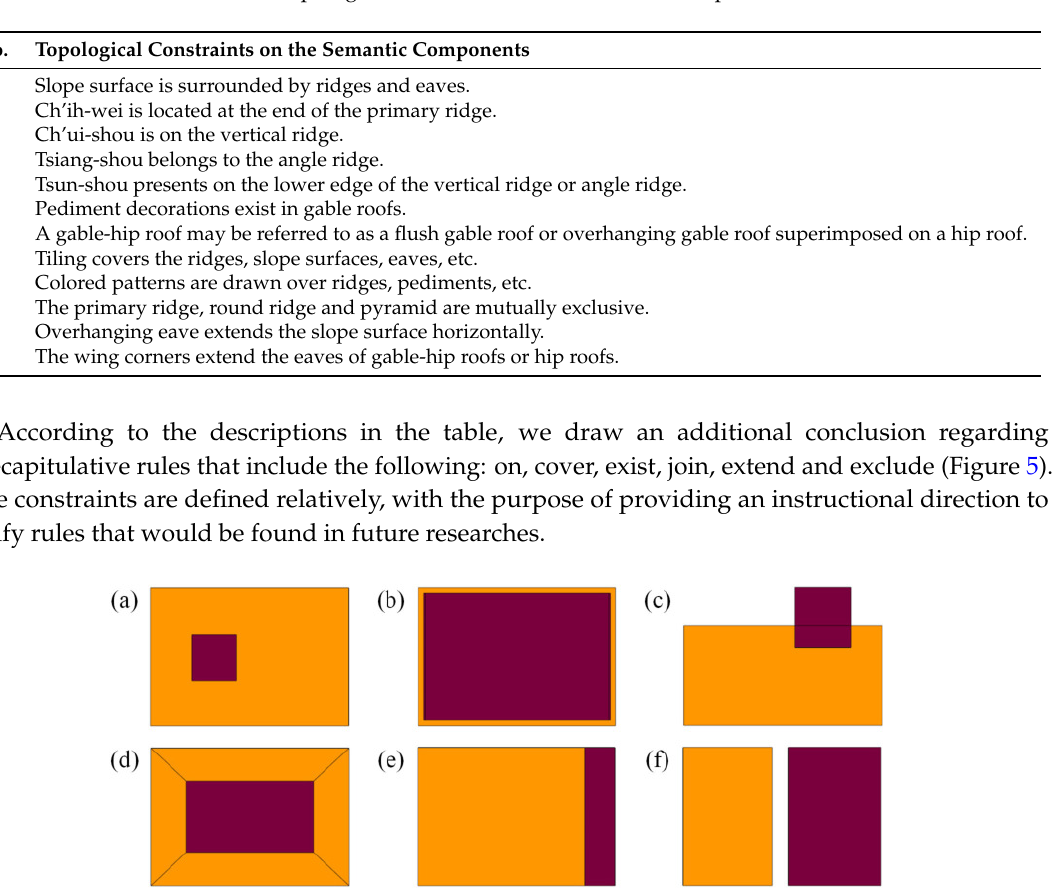
Figure 5. Six recapitulative topological constraints of semantic components. ( a ) On; ( b ) cover; ( c ) exist; ( d ) join; ( e ) extend; ( f )